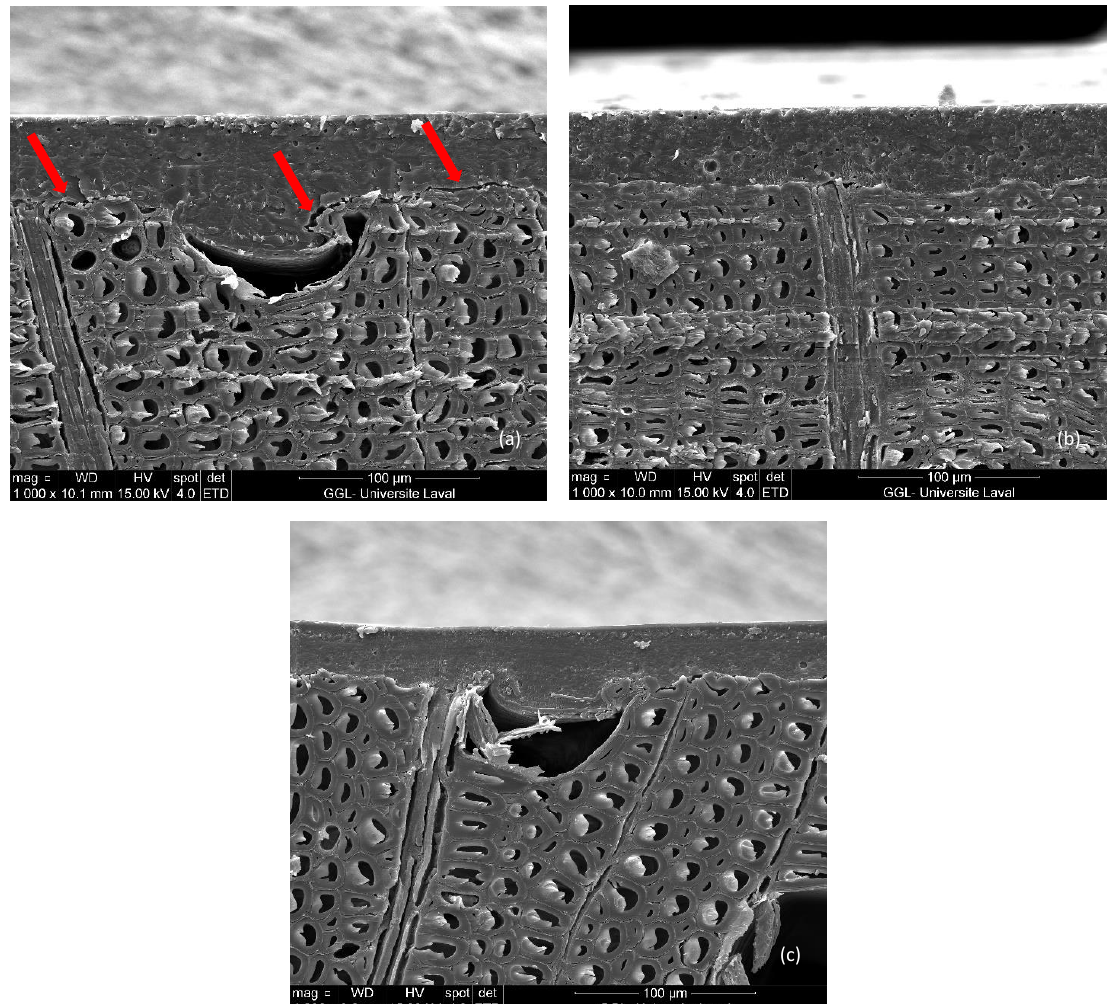
Figure 9. SEM images of the wood/coating interface, F0 ( a ), F1 ( b ) and F2 ( c ). Arrows show coating detachments of few microns wide from wood.